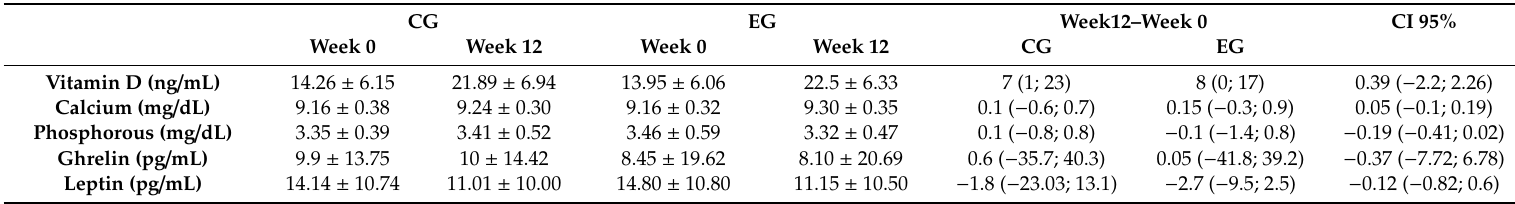
Table 5. Mineral and hormone concentrations before and after the